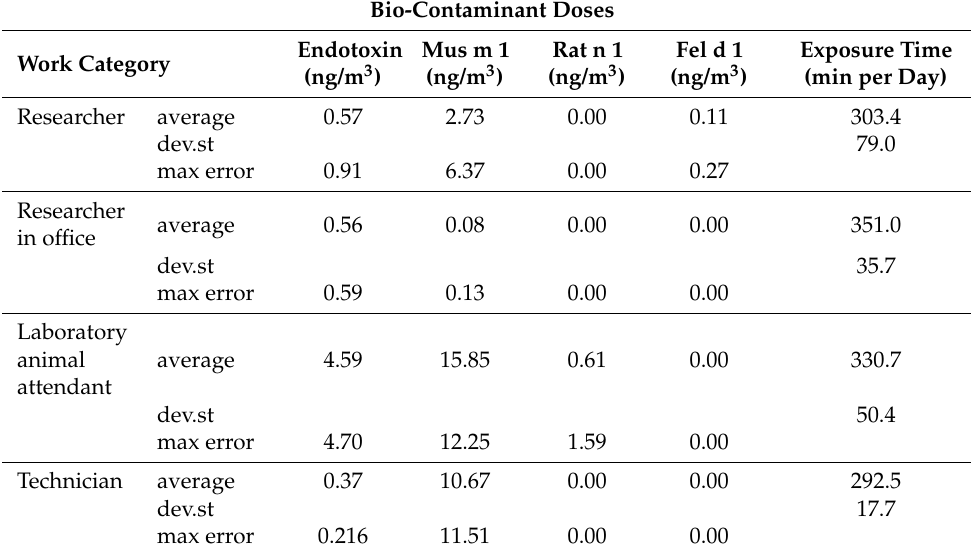
Table 1. Average dose of bio-contaminants by worker